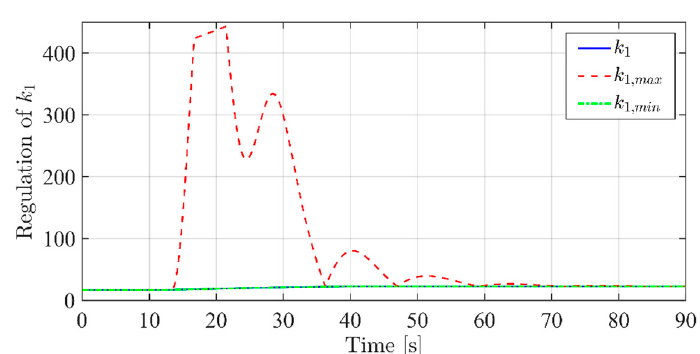
Figure 14. Performance comparison—injected thermal flows.